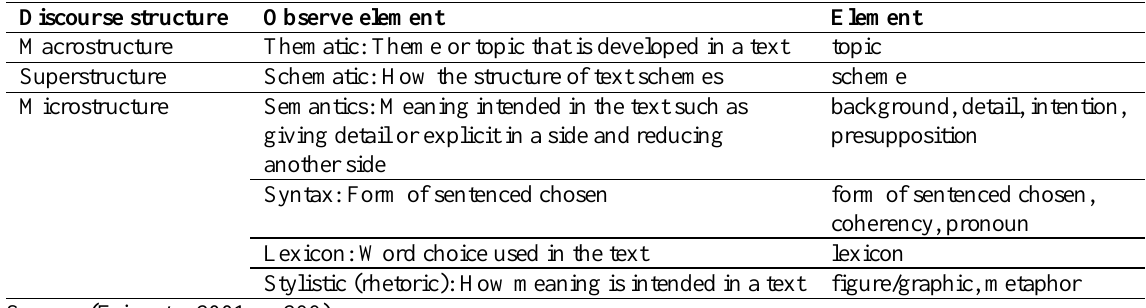
Table 1. van Dick’s Elements of